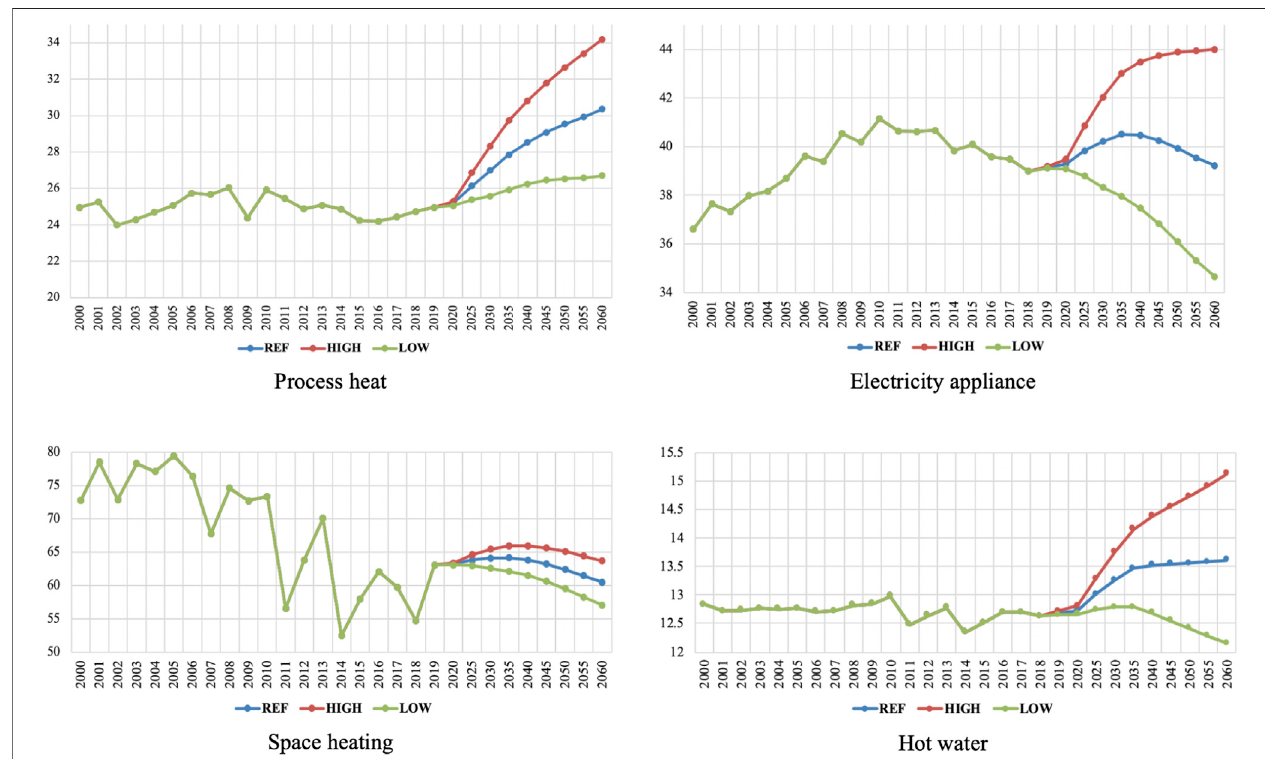
FIGURE 3 | History and projection of Swiss energy demand (TWh) for process heat, electricity appliance, space heating, and hot water in three scenarios.